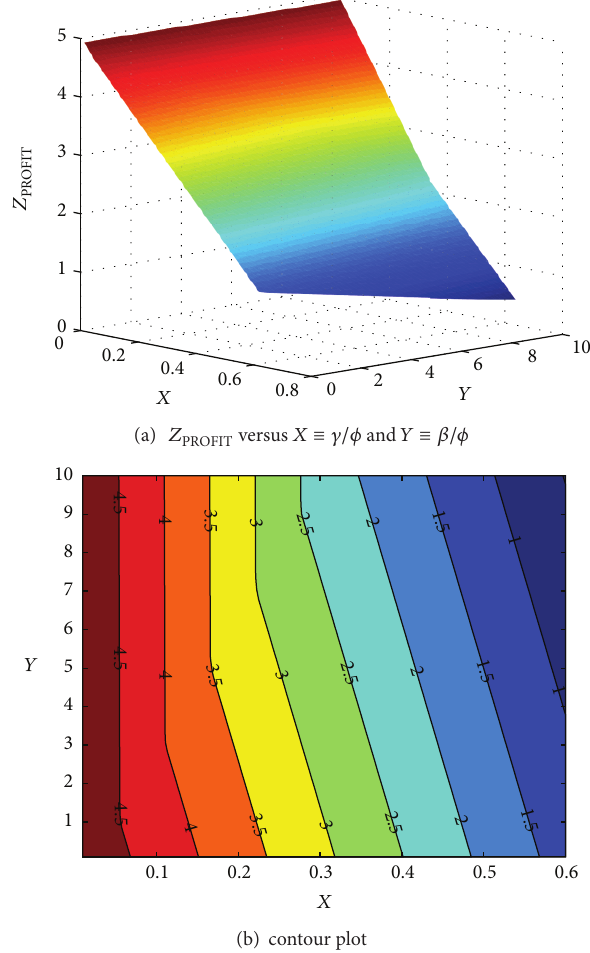
Figure2:Achievedprofitattheoptimalbufferallocationfor Θ 𝜏 = 5